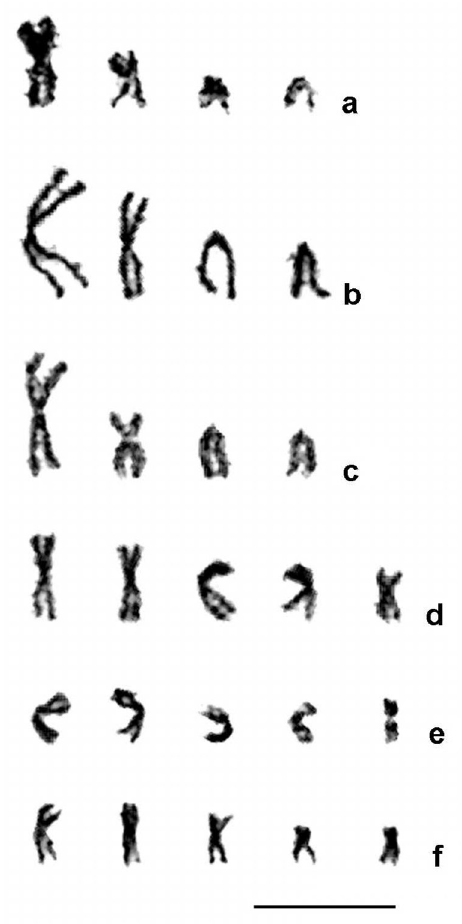
Figure 1. Haploid mitotic karyograms of six Aphelinus species. a A. atriplicis b A. certus c A. hordei d A. coreae e A. rhamni f A. daucicola . Species in the A. varipes complex have n = 4 versus n = 5 in the A. mali and A. dauci- cola complexes. Scale bar: 10